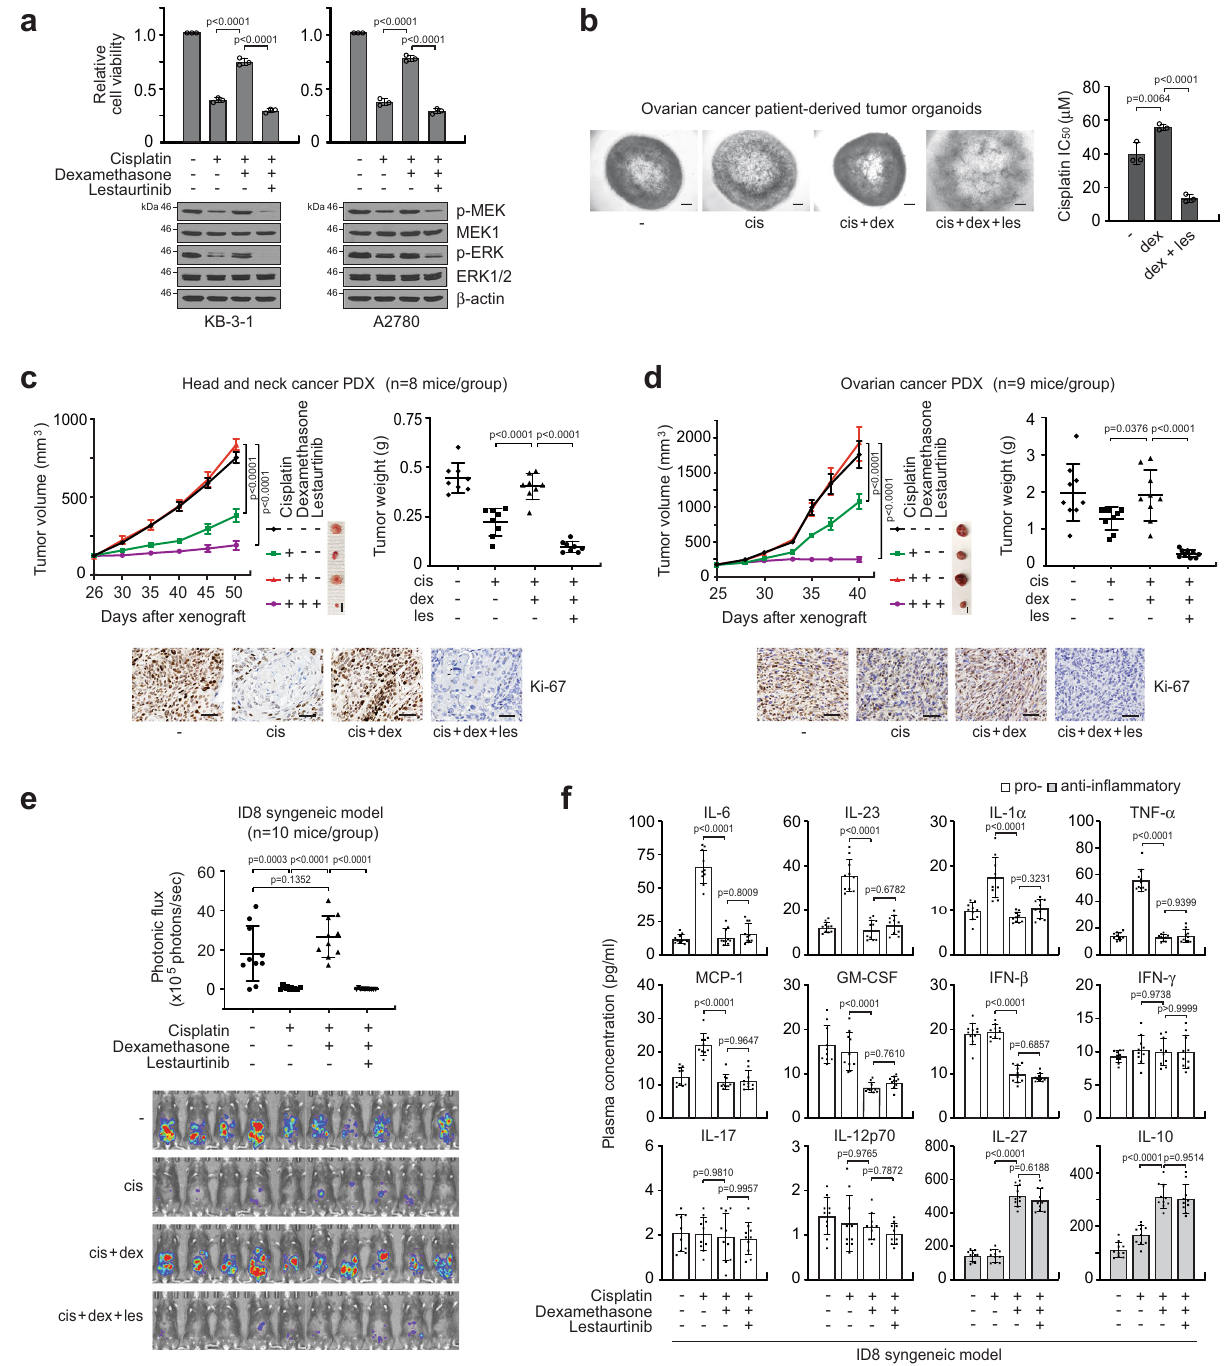
Fig. 8 Lestaurtinib suppresses dexamethasone-mediated GR-MAST1 activation and cisplatin resistance while not affecting the anti-in fl ammatory property of dexamethasone. a Effect of lestaurtinib on cell viability and MAPK activity of dexamethasone and cisplatin co-treated KB-3-1 and A2780 cells. Cells were treated with 100 nM lestaurtinib, 500 nM dexamethasone, and 3 μ g/ml cisplatin. b Effect of lestaurtinib on growth of ovarian cancer patient- derived xenograft tumor organoid treated with cisplatin and dexamethasone. Images (left) and cisplatin IC 50 (right) of organoids are shown. Single cell suspended organoids were used for IC 50 analysis. Scale bars represent 100 μ m. c , d Effect of lestaurtinib on tumor growth of HNSCC ( c ) and ovarian cancer ( d ) PDX mice receiving cisplatin and dexamethasone treatment. Cisplatin (5 mg/kg i.p. twice/week), dexamethasone (0.1 mg/kg i.p. twice/week) and lestaurtinib (20 mg/kg s.c. daily) were treated. Tumor volume (left), tumor weight (right), and Ki-67 IHC staining of PDX tumors (bottom) are shown for HNSCC and ovarian PDX models. Scale bars represent 5 mm for tumor images and 50 μ m for Ki-67 staining. e , f Effect of lestaurtinib on tumor growth and in fl ammation of ID8-luc syngeneic mice receiving cisplatin and dexamethasone treatment. Syngeneic mice were treated as PDX mice. Average photonic fl ux and BLI ( e ) and plasma in fl ammation related cytokine pro fi le ( f ) from 10 mice/group at week 8 are shown. Data are mean ± SD from three independent biological replicates for a and b . In vivo data are from 8 mice for c , 9 mice for d , 10 mice for e and f . Data are mean ± SEM for tumor volume (left panels in c and d ) and SD for tumor weight (right panels in c and d ), photonic fl ux ( e ), and cytokine pro fi ling ( f ). Statistical analyses were performed by two-way ANOVA for tumor volume and one-way ANOVA for the rest. Source data are provided as a Source Data fi